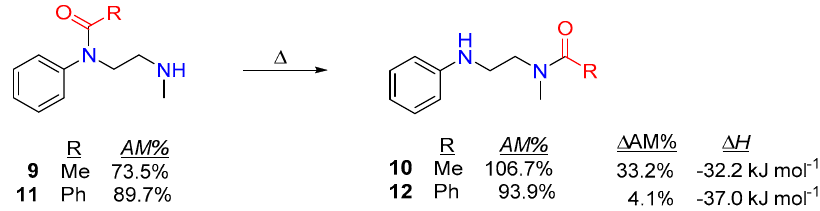
Figure 7. Typical example of intramolecular transamidation rearrangement, with the corresponding amidicity values (AM%) as well as amidicity ( Δ AM) and enthalpy change ( Δ H), computed at B3LYP/6-31G(d,p) level of theory.